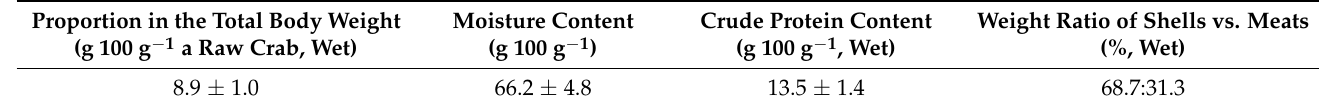
Table 1. The amount of the residues obtained from 1st body muscle separation and their crude protein content.